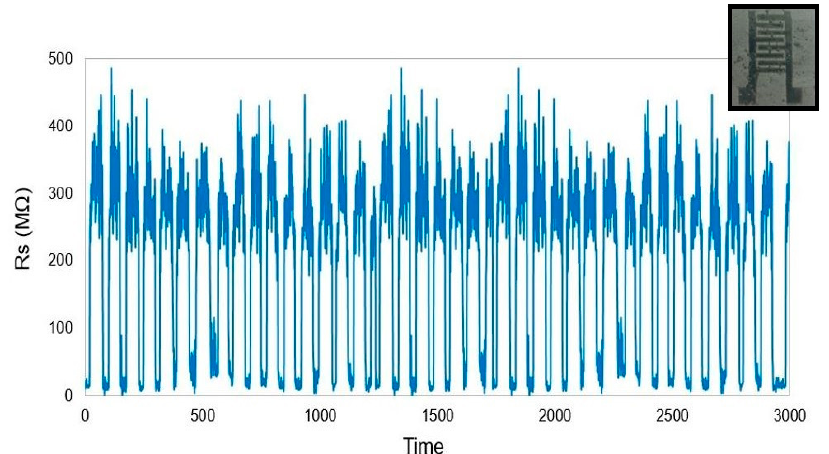
Figure 7. Response of the sensors for continuous bending cycles.